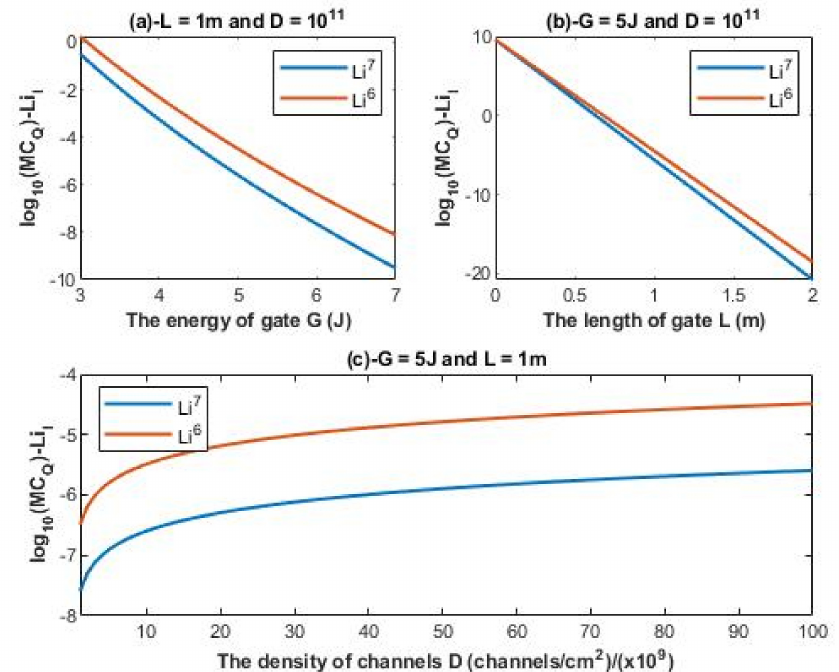
Figure 7. ( a ): The figure represents the relationship between the common logarithm of quantum ( MC ) − Li membrane conductance of the intracellular lithium isotopes log I and the energy of the Q 10 gate G by setting L = 1 m and D = 10 11 and across the range of G from 3 J to 7 J. ( b ): The figure represents the relationship between the common logarithm of quantum membrane conductance of ( MC ) − Li = 5 J the intracellular lithium isotopes log I and the length of the gate L by setting G Q 10 and D = 10 11 and across the range of L from 0 m to 2 m. ( c ): The figure represents the relationship between the common logarithm of quantum membrane conductance of the intracellular lithium ( MC ) − Li = 5 J and L = 1 m and across isotopes log I and the density of channels D by setting G Q 10 the range of D from 10 9 to 10 11 channels/cm 2